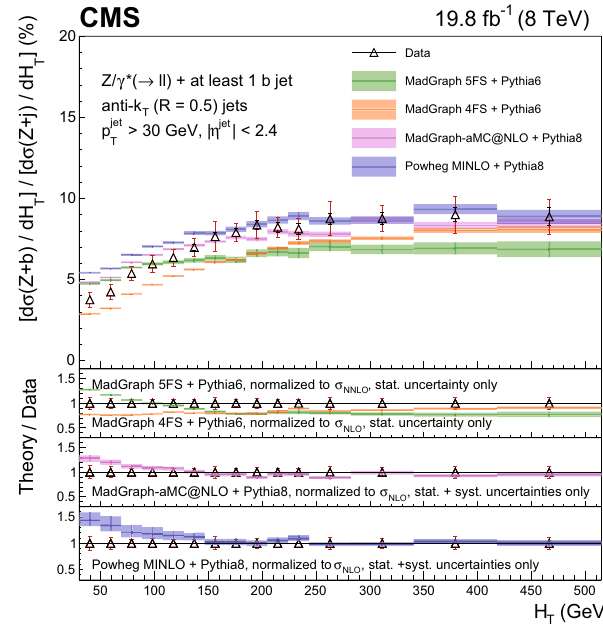
Fig. 7 Differential fiducial cross section for Z(1b) production as a functionof H T ( left ),andthecrosssectionratioforZ(1b)andZ+jetspro- ductionasafunctionof H T ( right ),comparedwiththe MadGraph 5FS, MadGraph 4FS, MadGraph5 _a MC@NLO , and powheg minlo the- oretical predictions ( shaded bands ), normalized to the theoretical cross sections described in the text. For each data point the statistical and the